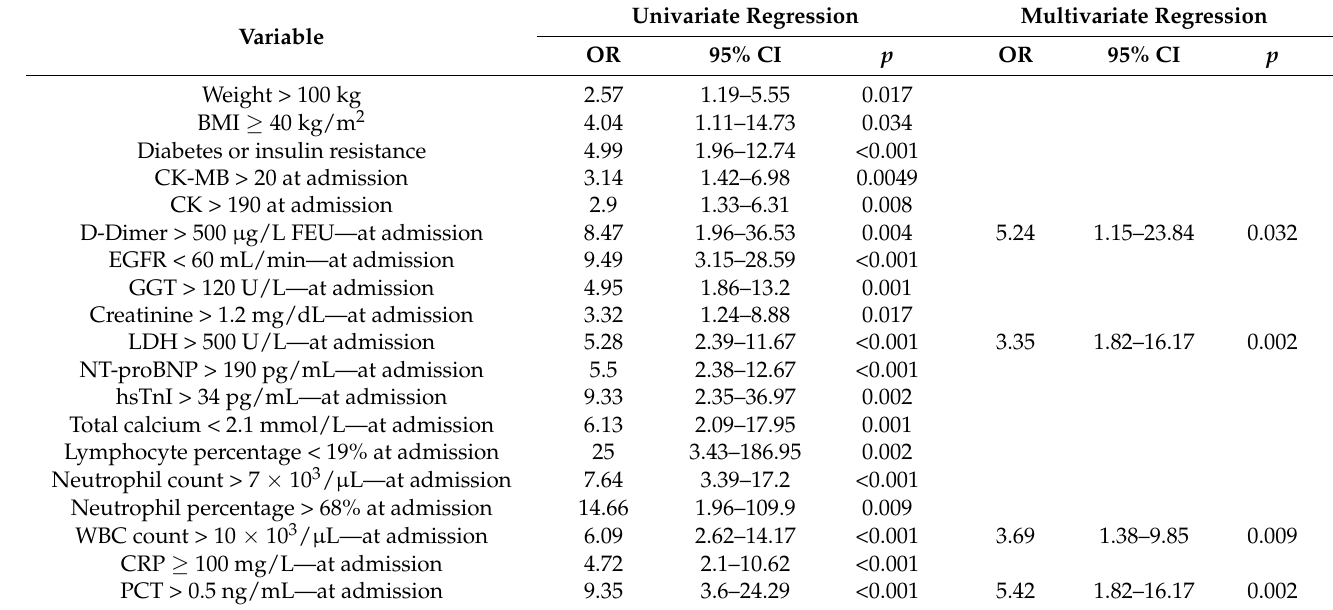
Table 10. Univariate and multivariate logistic regression analysis of selected clinical characteristics and laboratory parameters at admission for the prediction of ICU